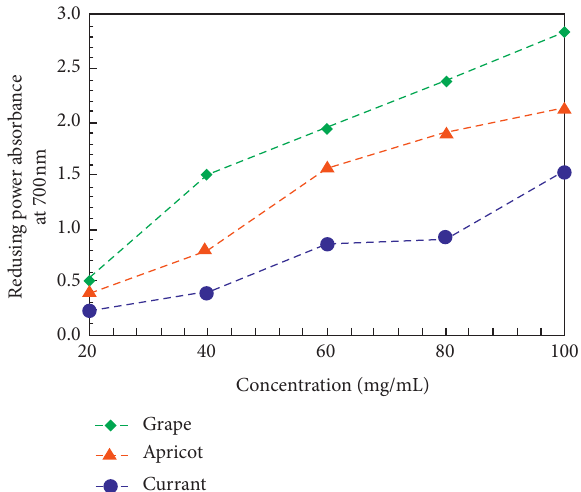
Figure 7: Reducing power of the aqueous black currant, apricot, and grape pomace extracts evaluated by the FRAP